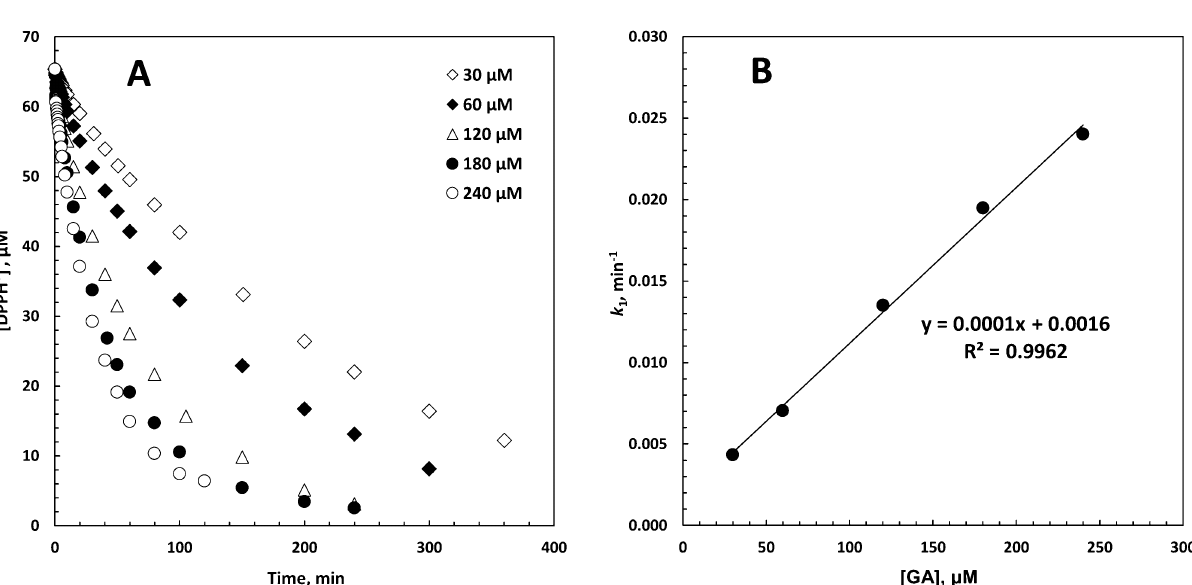
Figure 1. ( A ) The kinetic curve of [DPPH · ] decay in the presence of gallic acid (GA) in 1,4-dioxane. ( B ) The pseudo-first-order rate constant k 1 as a function of GA concentration in 1,4-dioxane.